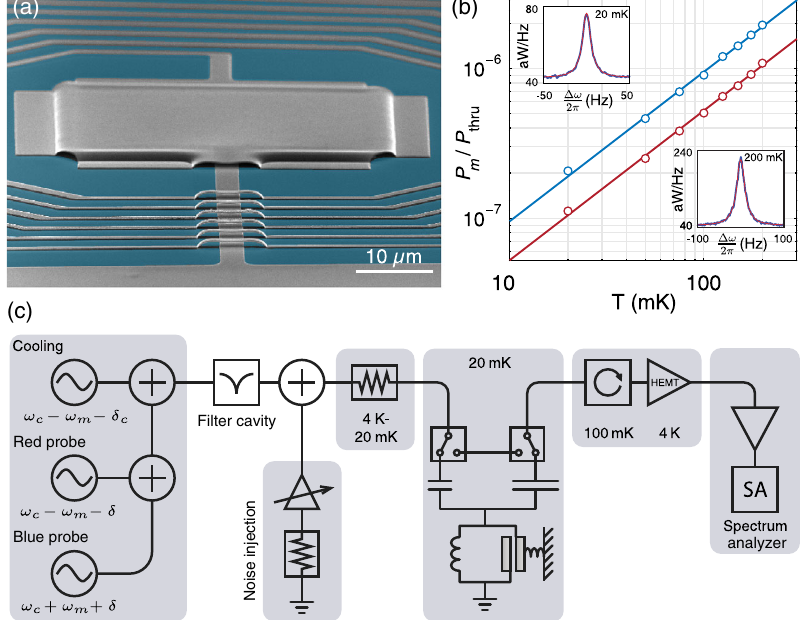
FIG. 2. Device, calibration, and measurement scheme. (a) Electron micrograph of the measured device. A suspended aluminum (gray areas) membrane patterned on silicon (blue background) forms the electromechanical capacitor. It is connected to the surrounding spiral inductor to form a microwave resonator. Out of view, coupling capacitors on either side of the inductor couple the device to input and output coplanar waveguides. (b) Motional sideband calibration. The cryostat temperature is regulated while the mechanical mode is ω δ (blue) and at ω − ω − δ (red), with detunings δ ¼ 2 π × 500 Hz. The weakly probed with microwave tones set at ω c þ m þ c m observed linear dependence provides the calibration between the normalized sideband power and the mechanical occupation factor. − δ Þ . (c) Schematic Insets: Up-converted motional sideband spectra collected at 20 mK (top) and 200 mK (bottom), with Δ ω ¼ ω − ð ω c of the microwave-measurement